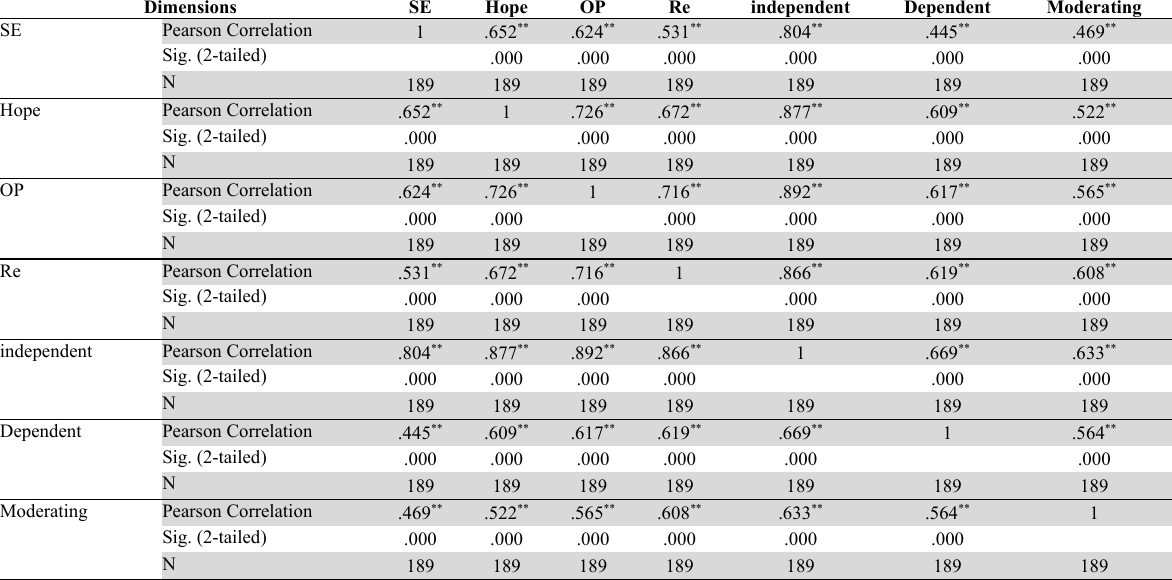
Matrix of correlation between dimensions